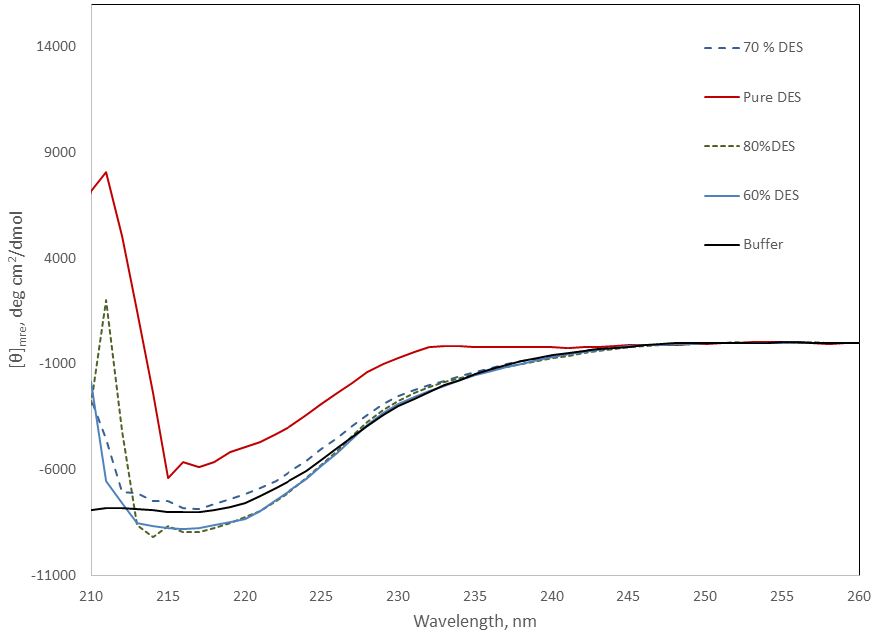
Figure 5. Far-UV region of the CD spectra of Amy A in pure phosphate buffer and in choline chloride:urea (2:1) DES/buffer mixtures (20 to 100% ( v/v ) of DES) at 25 °C. Pure DES solid red line; 80% DES dashed green line; 70% DES blue dashed line; 60% DES blue solid line; buffer, black solid line.